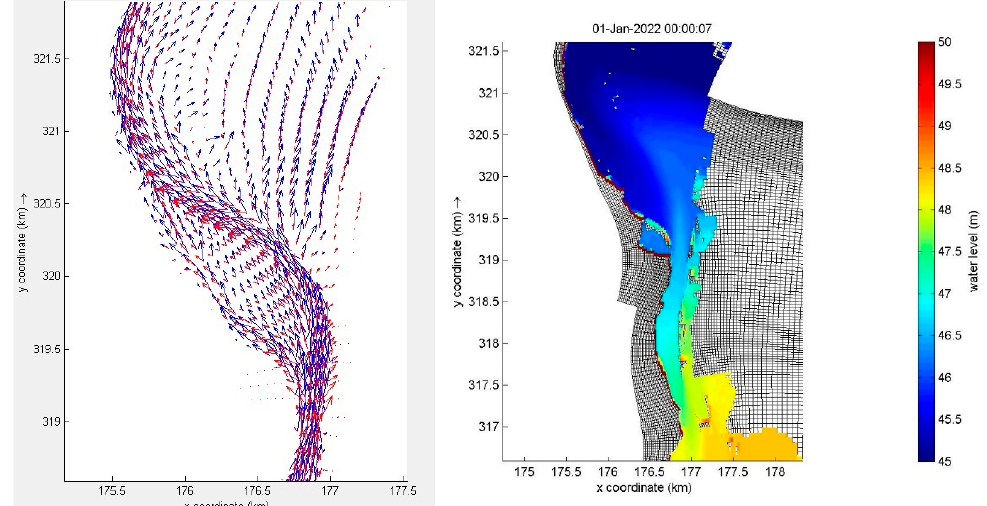
Figure 9. Illustration of water levels ( right panel ) and currents for the Grensmaas with currents in Delft3D-FLOW in blue and currents for “Semi-impl” in red ( left panel ).